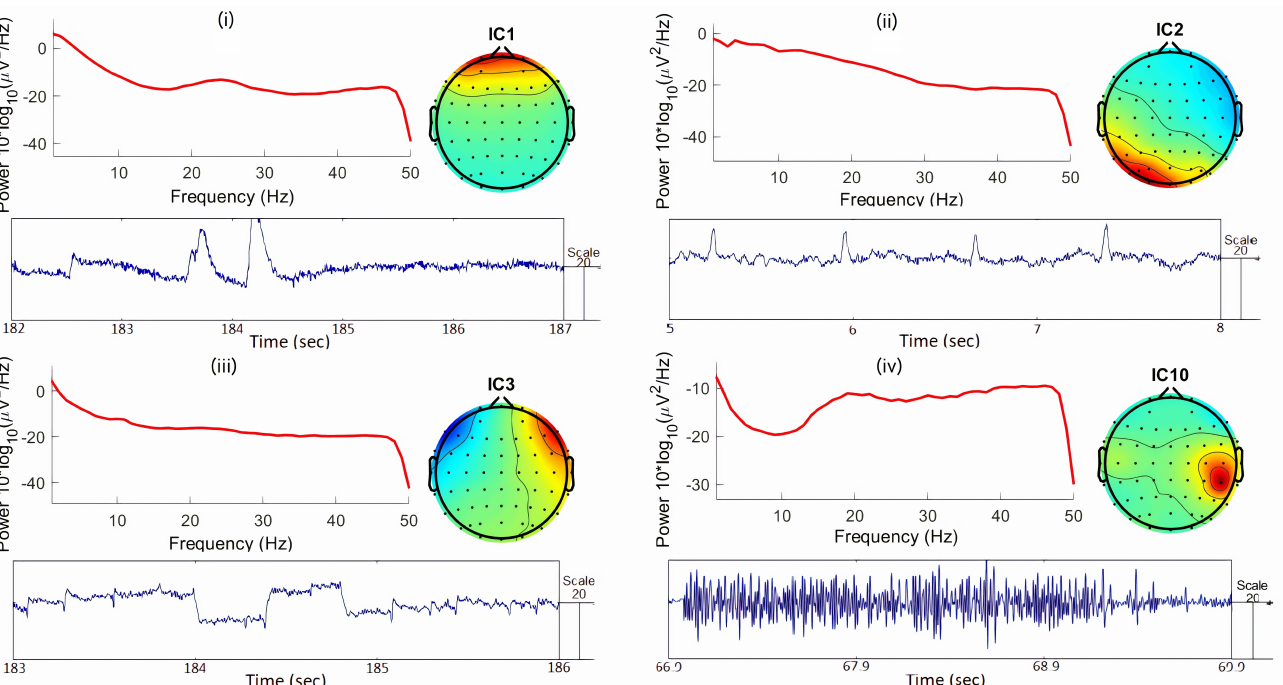
Figure 4. Examples of some artifact components that were identified and removed: ( i ) In component IC1, an eye blinking artifact component can easily be recognized; ( ii ) component IC2 contains cardiac artifact; ( iii ) component IC3 shows another example of ocular artifacts, the saccades/microsaccades; and ( iv ) component IC10 contains involuntary muscle